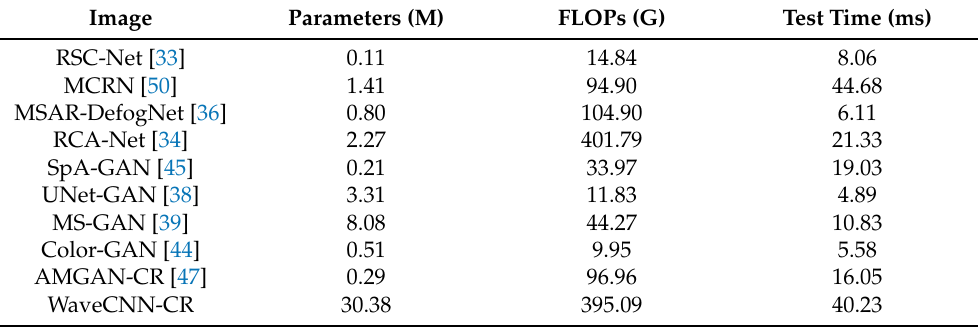
Table 10. Parameters, computational cost, and test time of different methods on the T-CLOUD dataset.